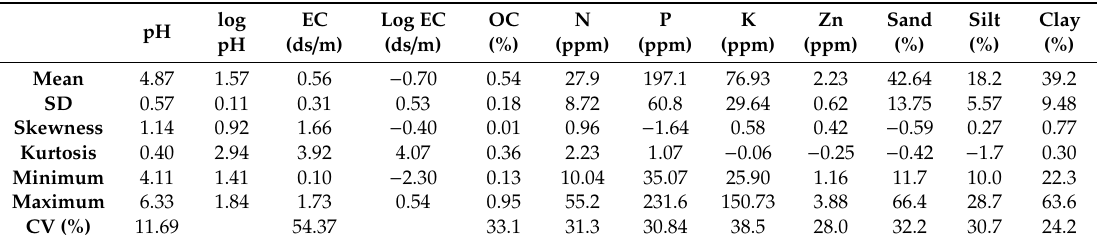
Table 3. Descriptive statistical analysis of physical and chemical properties of soil samples ( n = 70). log EC Log EC OC N pH pH (ds / m) (ds / m) (%)